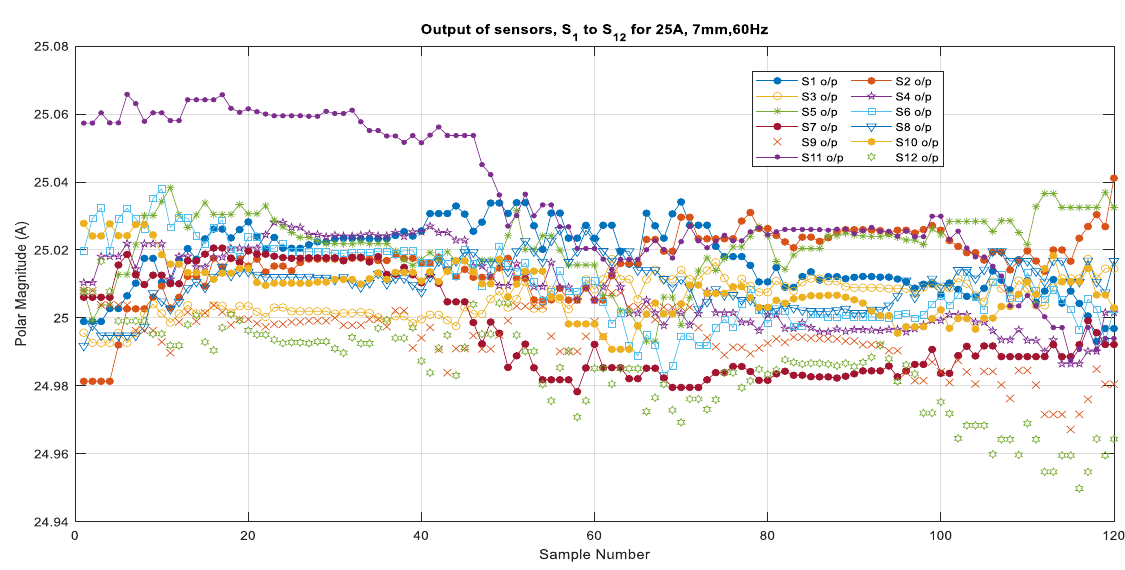
Figure 6. Output of all sensors for 5 A, 7 mm, 60 Hz.